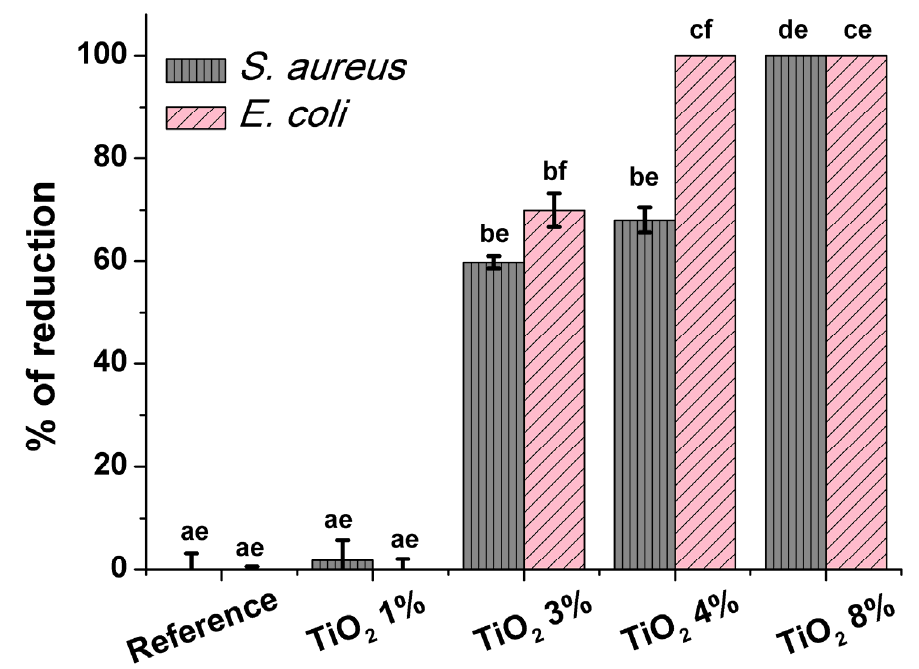
Figure 8. The antibacterial properties of functionalized paper after 24 h of incubation. Obtained data are presented as the mean of the percent of reduction compared to control ± standard error of the mean (SEM). Values with different letters are significantly different ( P < 0.05): a, b, c, d—statistically significant differences between the samples; e, f—statistically significant differences between the strains. Table 2. Viable bacterial counts (colony-forming unit (CFU)/mL) after 24 h contact time showing log reduction in treated sample compared to untreated sample.